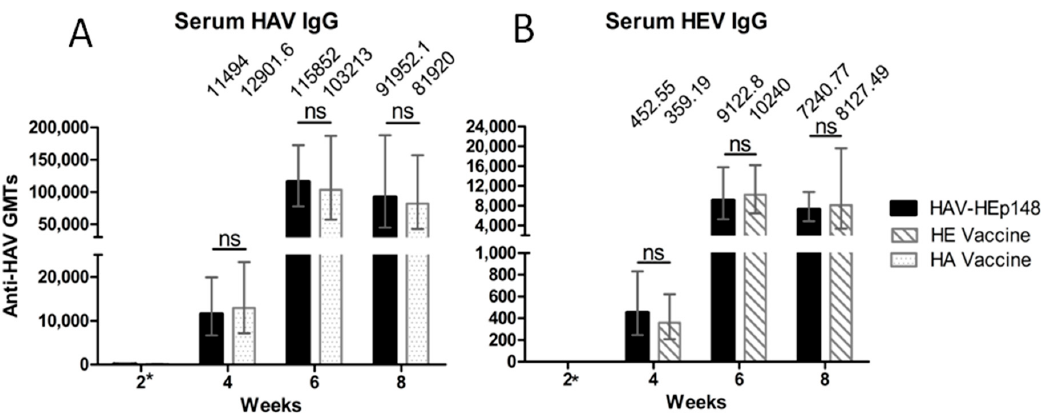
Figure 5. Profiles of HAV- and HEV-specific IgG production in humoral immune responses following vaccination. ( A ) Anti-HAV IgG and ( B ) anti-HEV IgG were detected by indirect ELISA after immunization of the immunized groups, as indicated. Each serum effective dose is the reciprocal value of the maximum positive dilution. The geometric mean titer (GMT) values are presented at the tops of the graphs. Error bars represent the 95% confidence level (Cl). *, IgG cannot be detected at 1:80 serum dilution. ns, no significant difference.